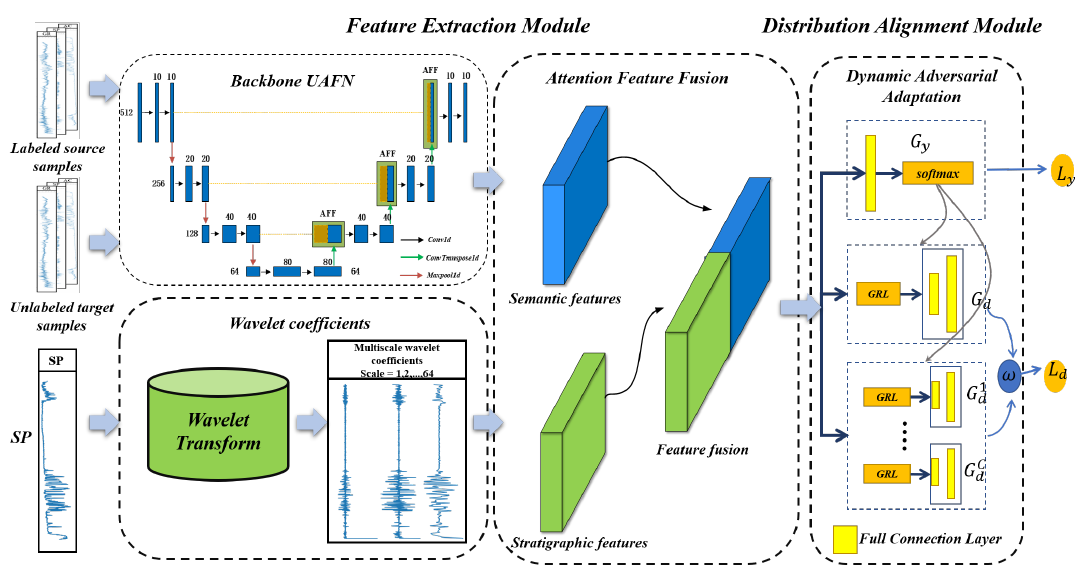
Figure 4. The Proposed Method of Cross-well Lithology